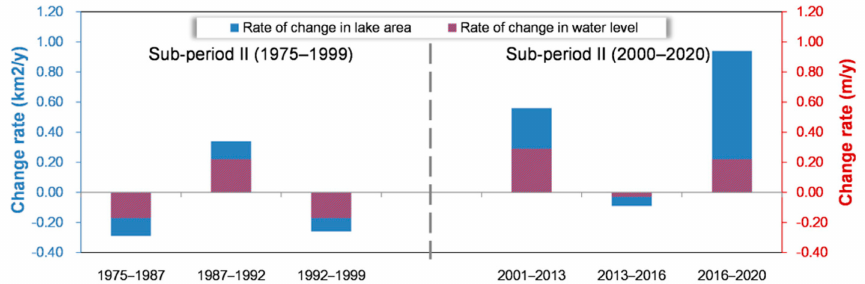
Figure 13. Rates of change in the area and water level of Gahai Lake over different periods.